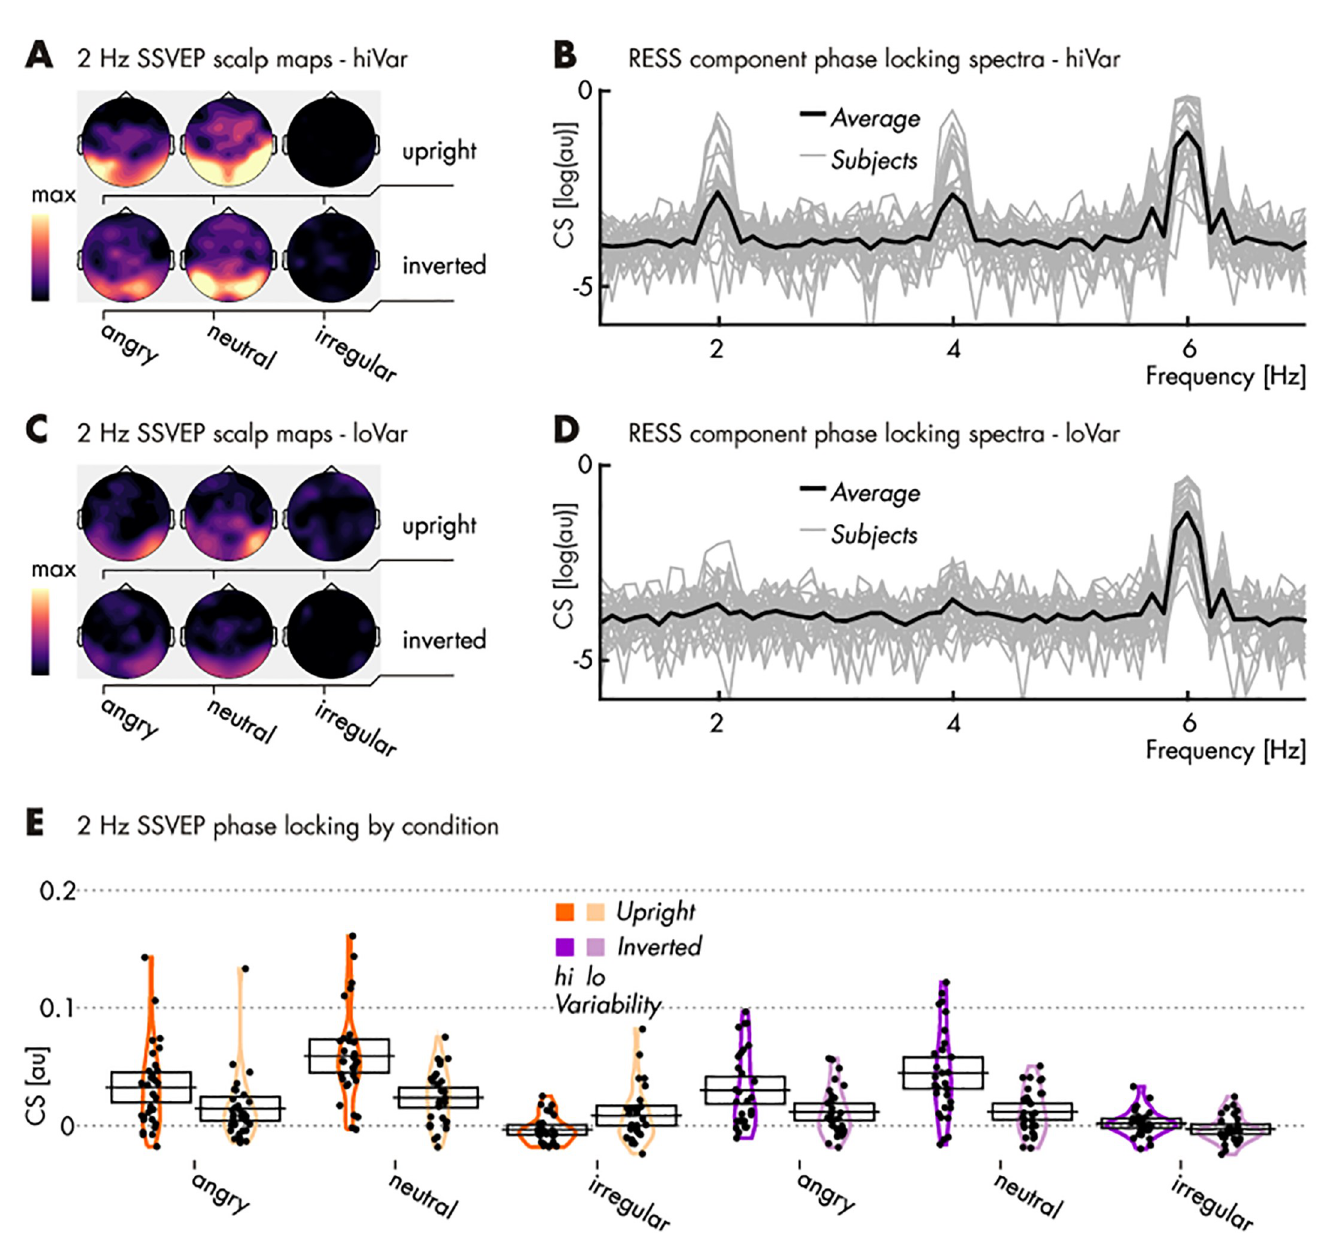
Fig 6. Spectral characteristics of EEG responses to stimulation in Experiment 2 . ( A ) Topographical distributions of phase-locking, quantified as cosine similarity (CS), at the regularity frequency of 2 Hz for high variance stimuli. Note the lack of phase-locking, i.e. consistent responses to the irregular stimulation conditions (maps same scale, in arbitrary units); ( B ) CS index of phase locking across the EEG spectrum (arbitrary scale) with the group average superimposed on single subject spectra, based on RESS spatial filter projections and collapsed across conditions featuring a regular presentation of high variance stimuli (i.e., excluding irregular stimulation conditions for their lack of signal; see A). For visualization only, CS has been converted to log(CS); ( C & D ) Same as in panels A & B (identical scale) but for 2 Hz SSVEPs driven by low variance stimulation; ( E ) CS at the regularity frequency for each participant (single dots) and condition. Mean values are marked by horizontal black lines and 95% confidence intervals represented as transparent boxes. See Table 3 for specific results of statistical